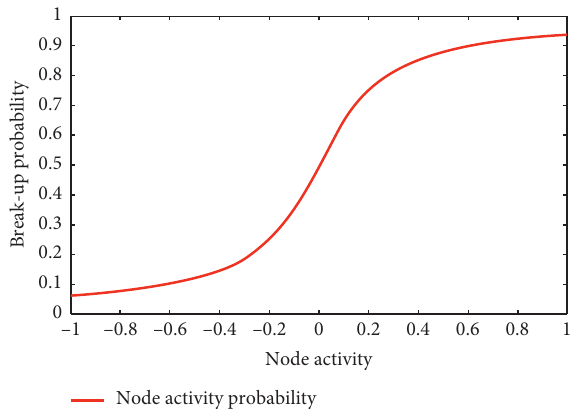
Figure 3: Node activity probability function